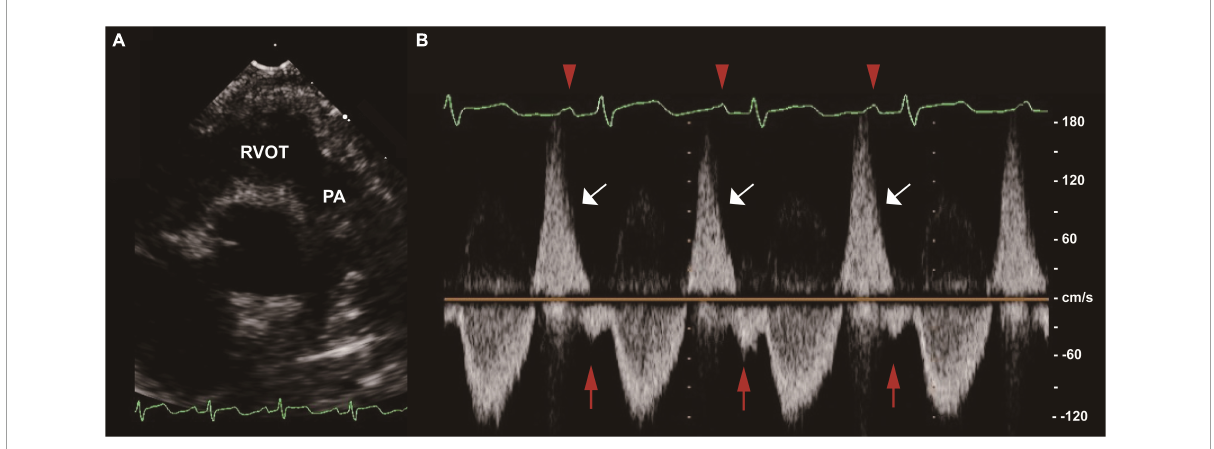
FIGURE1 End-diastolic forward flow (EDFF) in a patient after tetralogy of Fallot (TOF) repair. (A) Two-dimensional image of the RVOT and PA in the parasternal long axis view. (B) Pulse wave Doppler of the main PA showing pulmonary regurgitation (white arrow) and late diastolic pulmonary artery forward flow (red arrow), a low velocity forward flow immediately following the p wave of the electrocardiogram (red arrowhead) and preceding the systolic forward flow. EDFF, end-diastolic forward flow; PA, pulmonary artery; RVOT, right ventricular outflow tract; TOF, tetralogy of